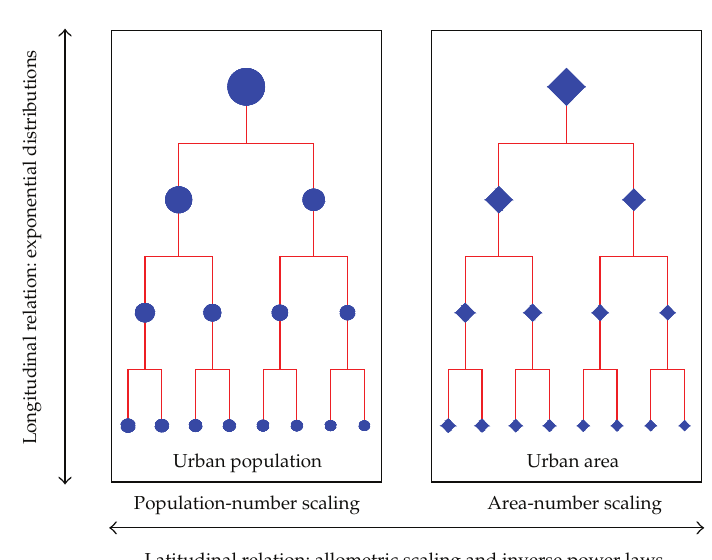
Figure 9: A schematic diagram on the longitudinal relations and latitudinal relations of urban hierarchy (cid:6) the first four classes (cid:7) .